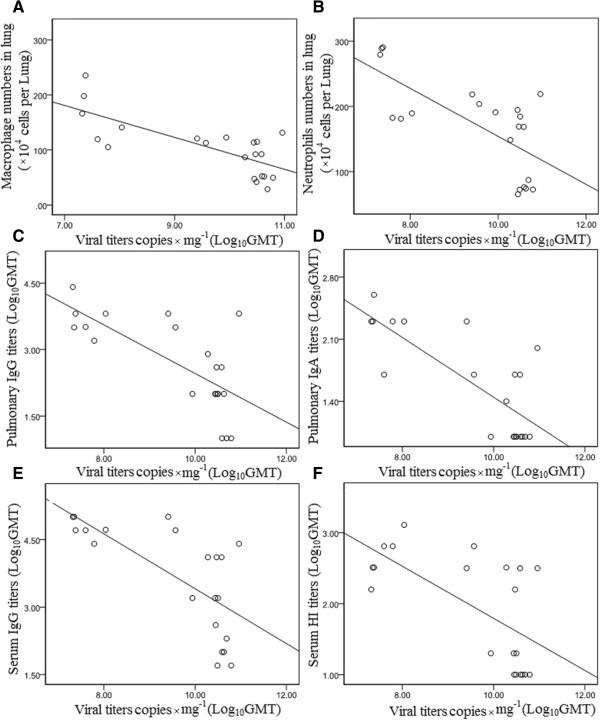
Scatter plot of Table2. (A) Scatter plot of macrophage numbers × 104 per lung and viral copies × mg−1(Log10GMT) of mice infected with A/PR/8/34 (H1N1) influenza viruses; (B) Scatter plot of neutrophils numbers × 104 per lung and viral copies × mg−1(Log10GMT) of mice infected with A/PR/8/34 (H1N1) influenza viruses; (C) Scatter plot of pulmonary IgG titers and viral copies × mg−1(Log10GMT) of mice infected with A/PR/8/34 (H1N1) influenza viruses; (D) Scatter plot of pulmonary IgA titers and viral copies × mg−1(Log10GMT) of mice infected with A/PR/8/34 (H1N1) influenza viruses; (E) Scatter plot of serum IgG titers and viral copies × mg−1(Log10GMT) of mice infected with A/PR/8/34 (H1N1) influenza viruses; (F) Scatter plot of serum HI titers and viral copies × mg−1(Log10GMT) of mice infected with A/PR/8/34 (H1N1) influenza viruses.